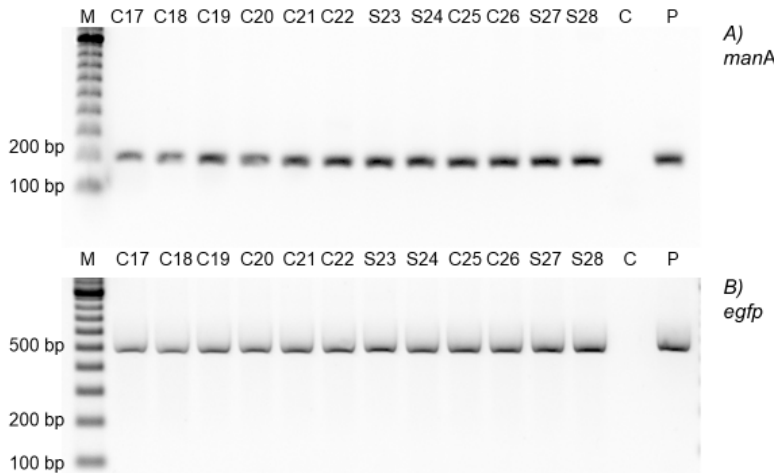
Figure 1. Endpoint polymerase chain reaction (PCR) for man A and egfp coding regions. ( A ) PCR for the man A coding region. ( B ) PCR for the egfp coding region. C : Citrus sinensis Osb. x Poncirus trifoliata